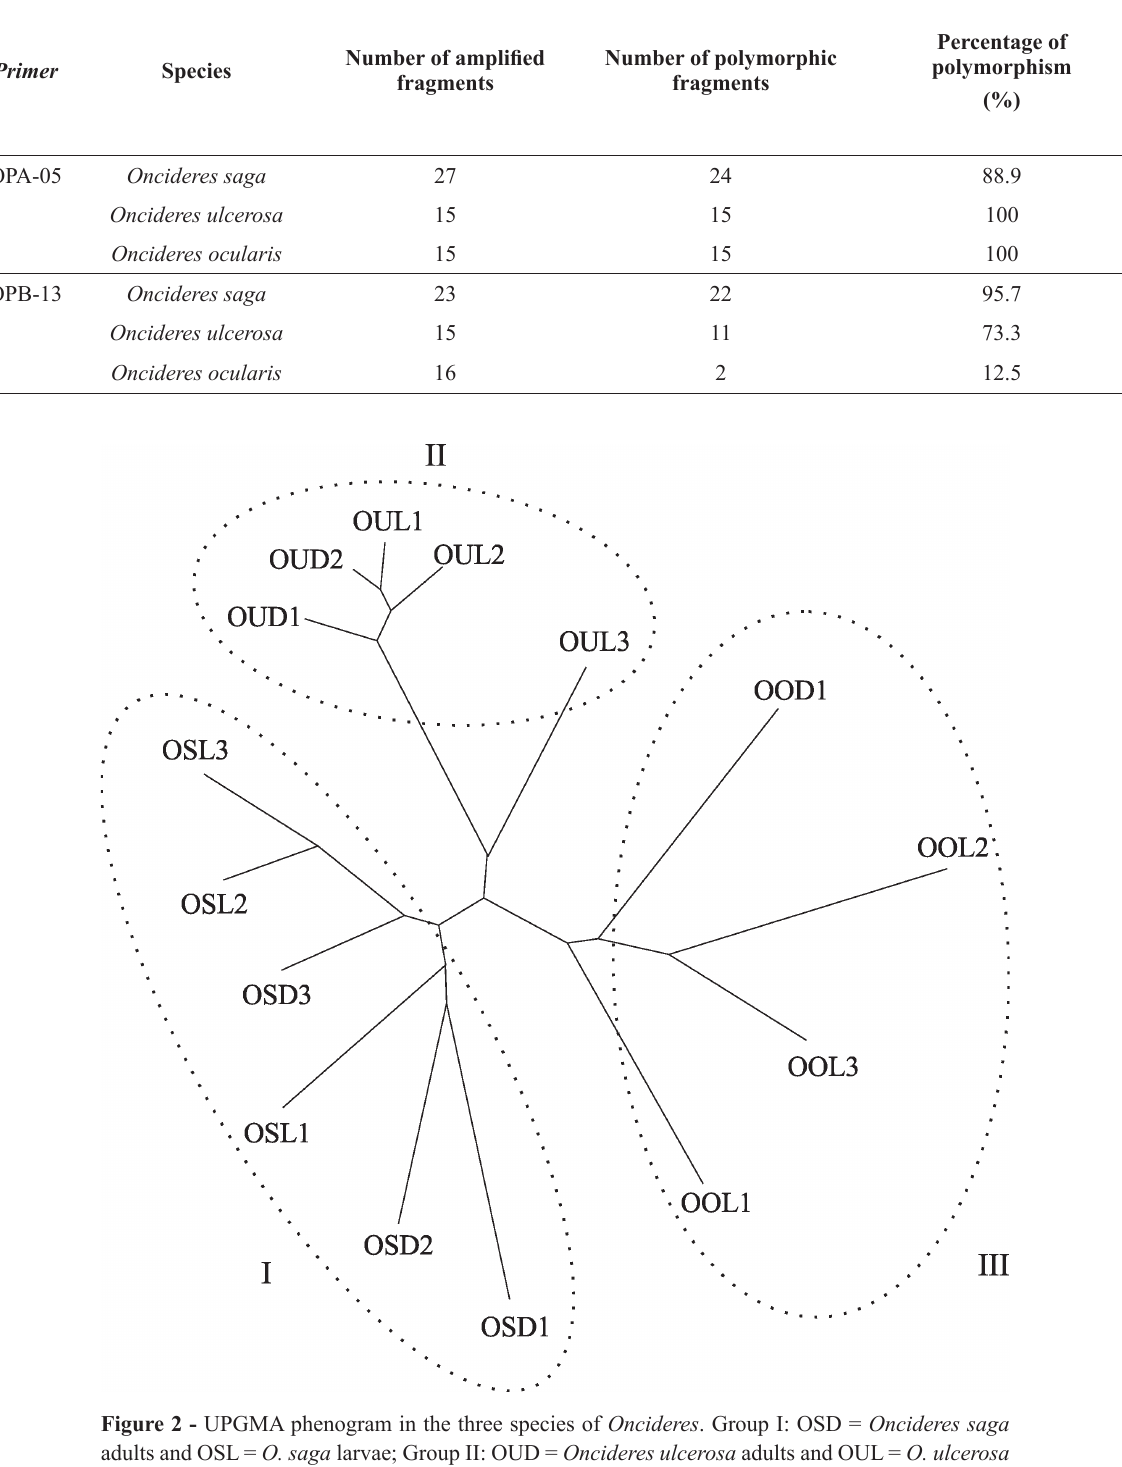
Polymorphism observed among Oncideres species according to the primer used in the RAPD reaction.